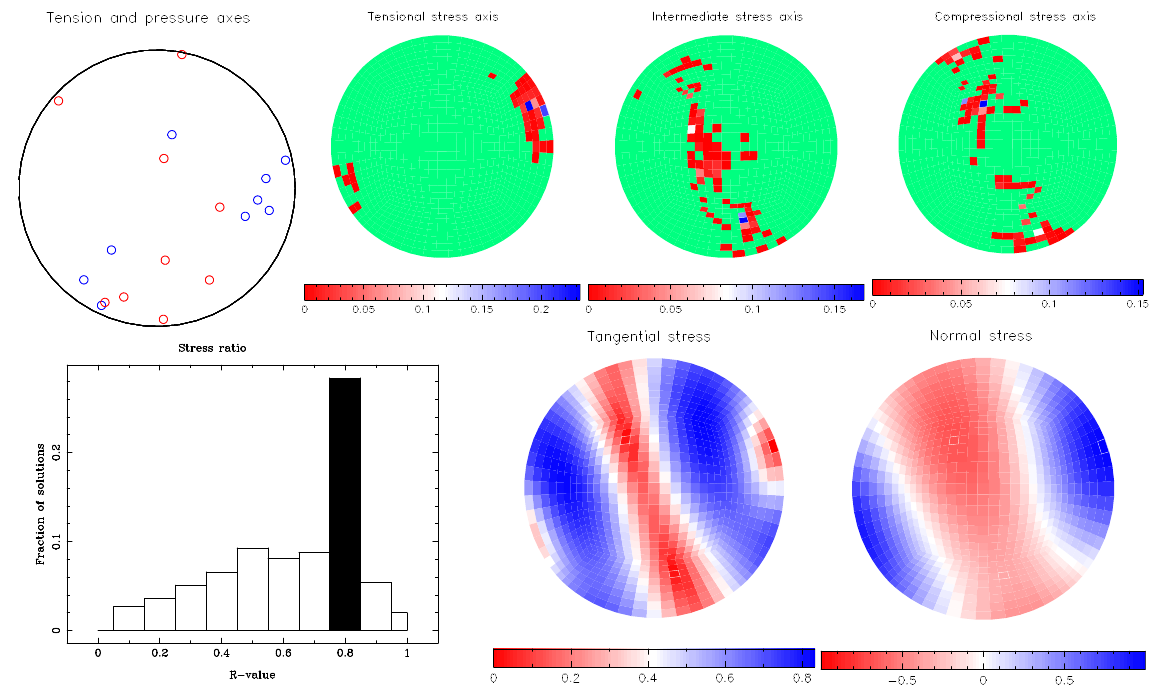
Fig. A4. Results of stress inversion for cluster of shallow earthquakes in the Kamilonisi basin. Explanation of subfigures is as in Fig. 5.